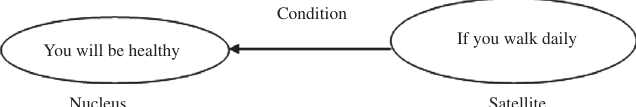
Figure 1. NRS Sequence for Example